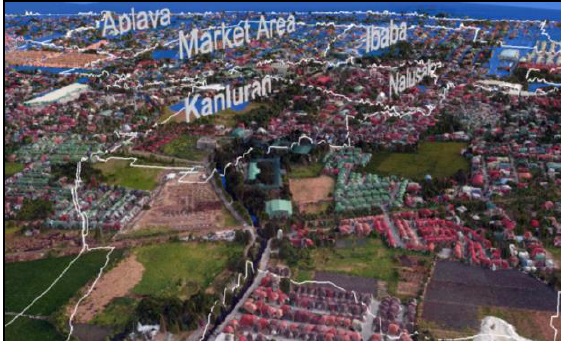
Figure 12. 3D visualization of the flooded area using